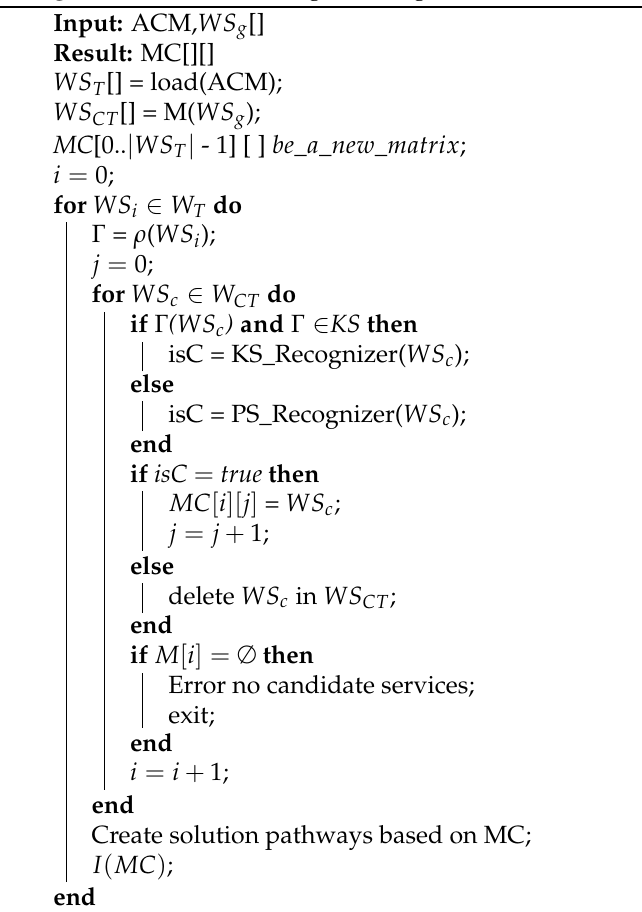
Algorithm 1: Pattern recognition algorithm of web